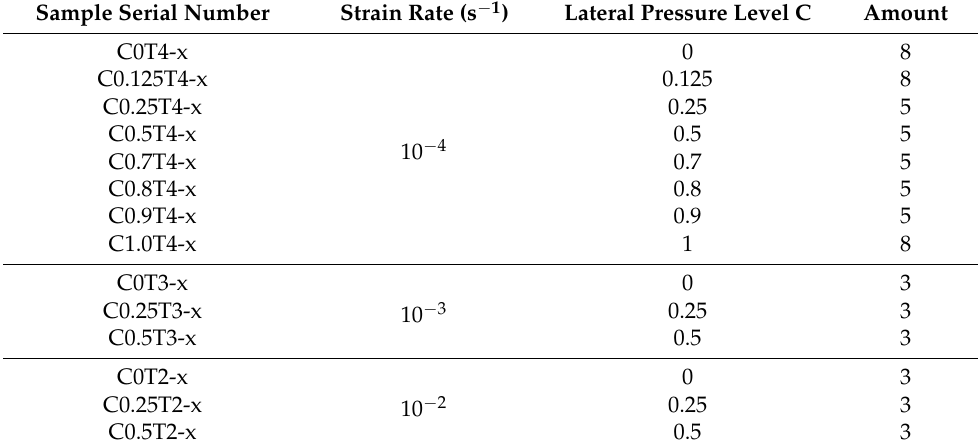
Table 3. Loading